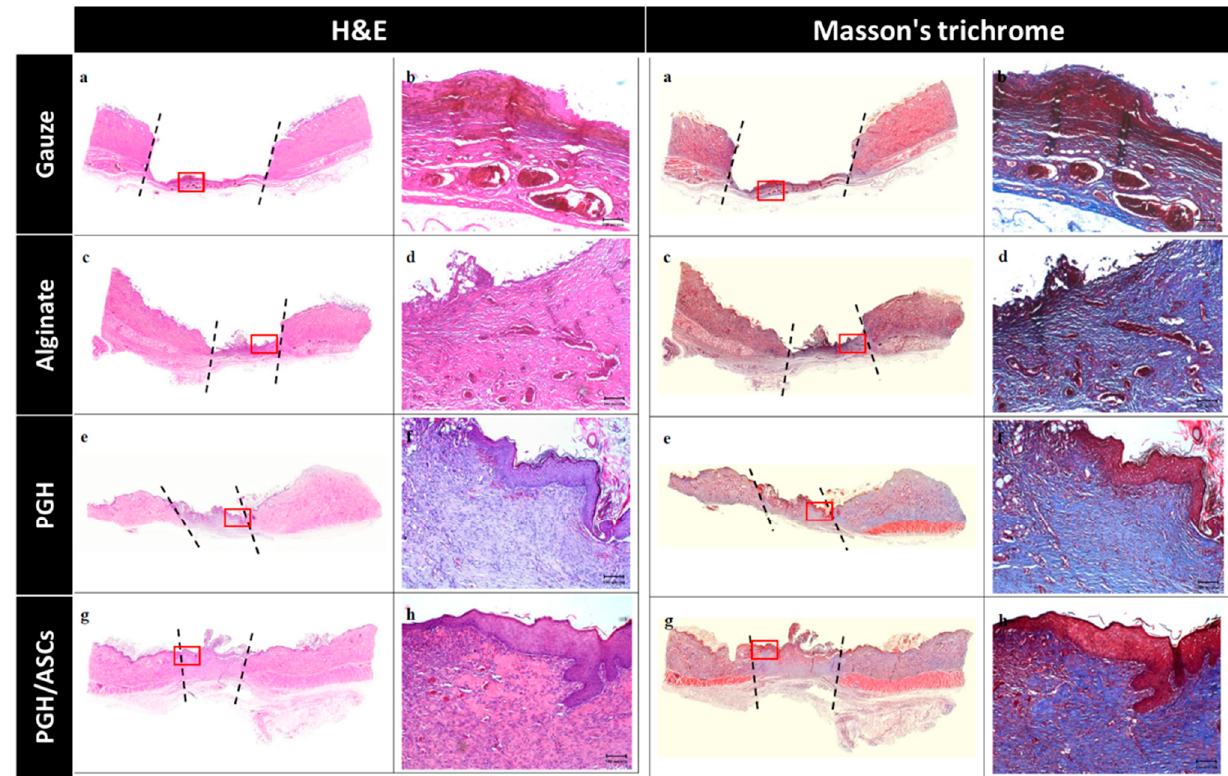
Figure 8. The histological analysis of wounds after treatment with gauze ( a , b ), alginate wound dressing ( c , d ), PGH ( e , f ), or PGH/ASCs ( g , h ) for 14 days by hematoxylin and eosin (H&E) and Masson’s trichrome staining (bar = 100 μ m). A low-power image of each wound is shown to the left, with dotted lines indicating the boundary of created wounds. A high-power image taken from the red rectangle in the low-power image is shown to the right.